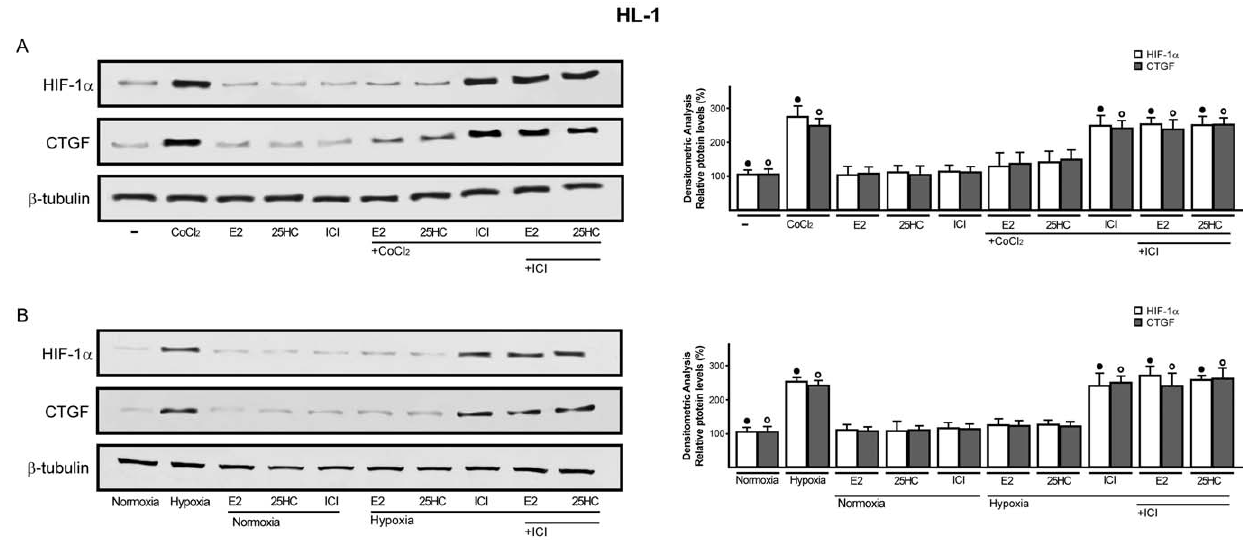
Figure 7. Immunoblots of HIF-1 a and CTGF from HL-1 cells. (A) cells were treated for 8h with 100 m M CoCl 2 or (B) exposed to hypoxia (2% O 2 ), in combination with 10nM E2, 1 m M 25HC and 10 m M ICI, as indicated. b -tubulin serves as loading control. Data (mean 6 SD) are representative of three independent experiments. Side panels show densitometric analysis of the blots, normalized to b -tubulin. ( N ), ( u ) indicate p , 0.05 for cells receiving vehicle (–) versus treatments or for cells cultured under normoxia versus cells exposed to hypoxia.